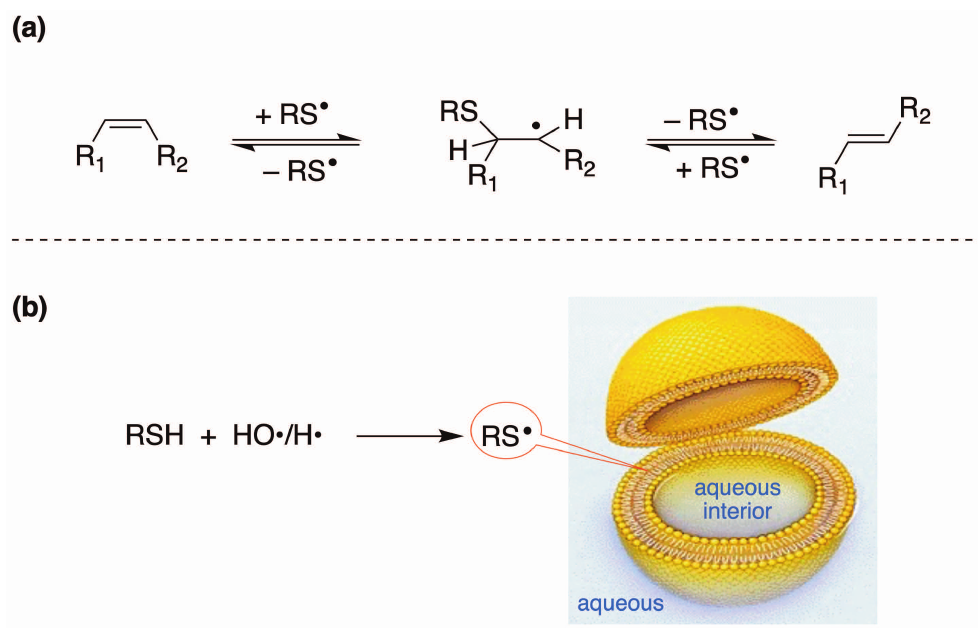
Figure 2. ( a ) Mechanism of thiyl radical catalyzed cis-trans double bond isomerization of unsaturated fatty acid moieties in phospholipids. ( b ) Thiyl radical generation in aqueous compartment and diffusion in the lipid compartment of large unilamellar vesicle (LUV) made of L- α -phosphatidylcholines